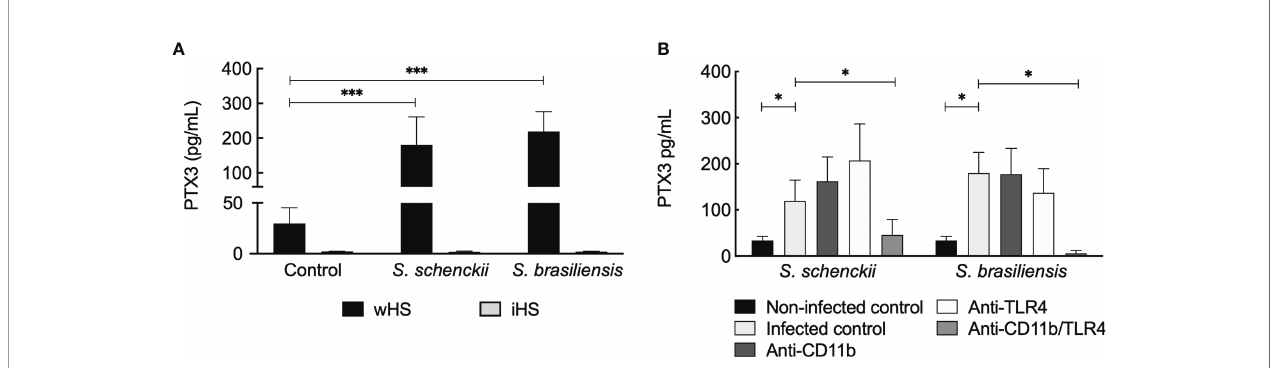
FIGURE 9 | Sporothrix schenckii and Sporothrix brasiliensis yeasts stimulate pentraxin 3 (PTX3) secretion by human monocyte-derived macrophages (hMDMs). (A) Only in the medium supplemented with whole human serum (wHS), S. schenckii or S. brasiliensis yeasts stimulated the secretion of PTX3 by hMDMs but not in the medium containing inactivated human serum (iHS), suggesting that the thermolabile complement system plays a role during this process. Statistical analysis was performed by ANOVA with Tukey ’ s multiple comparison posttest (***p < 0.001). (B) Complement receptor-3 (CR3) crosstalks with Toll-like receptor (TLR)4 in stimulating PTX3 secretion by hMDMs upon interaction with S. schenckii or S. brasiliensis yeasts. Statistical analysis was performed by ANOVA with Tukey ’ s multiple comparison posttest (*p < 0.05).